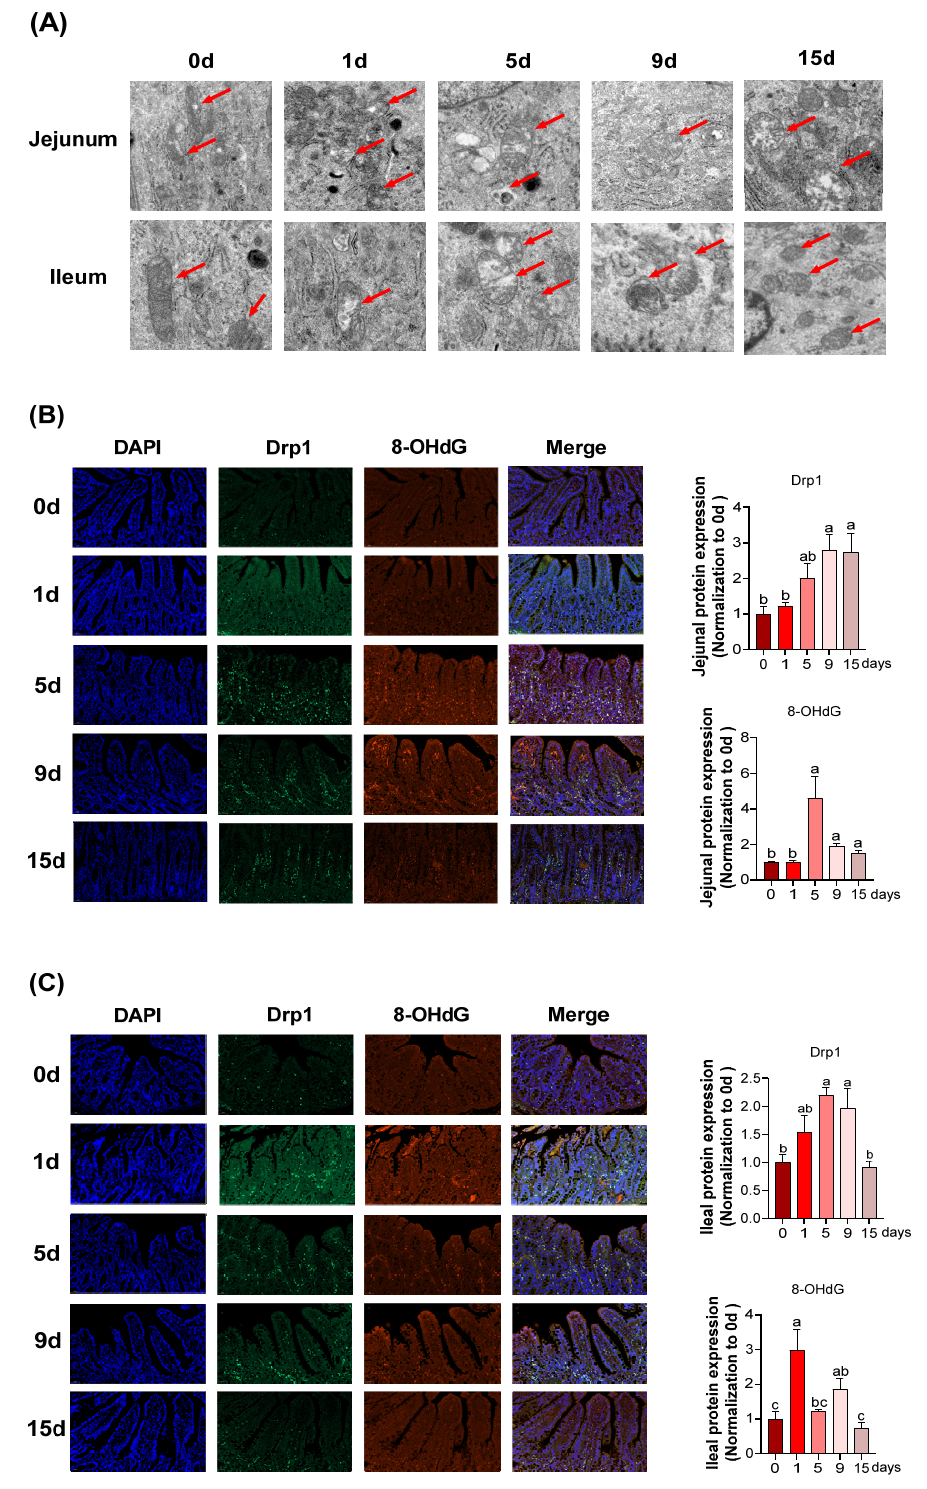
Figure 5. Intestinal mitochondria morphology and mitochondrial division-related proteins and DNA damage protein expresssion under LPS-induced chronic immune stress: ( A ) representative transmission electron microscopy images of intestinal mitochondria and the arrows in the figure point to the mitochondria; ( B , C ) representative images and quantification of Drp1 and 8-OHdG-positive proteins (( A ): jejunum; ( B ): ileum). Data represents the mean ± SEM. n = 6. a,b,c Mean values with different letters were considered to be significantly different ( p < 0.05).Drp1, dynamin-related protein 1; 8-OHdG, 8-hydroxy-2 (cid:48)